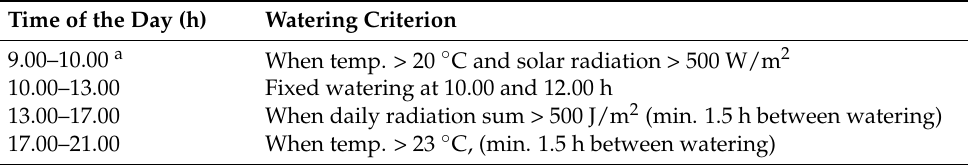
Table 1. Implemented watering strategy implemented in Experiment